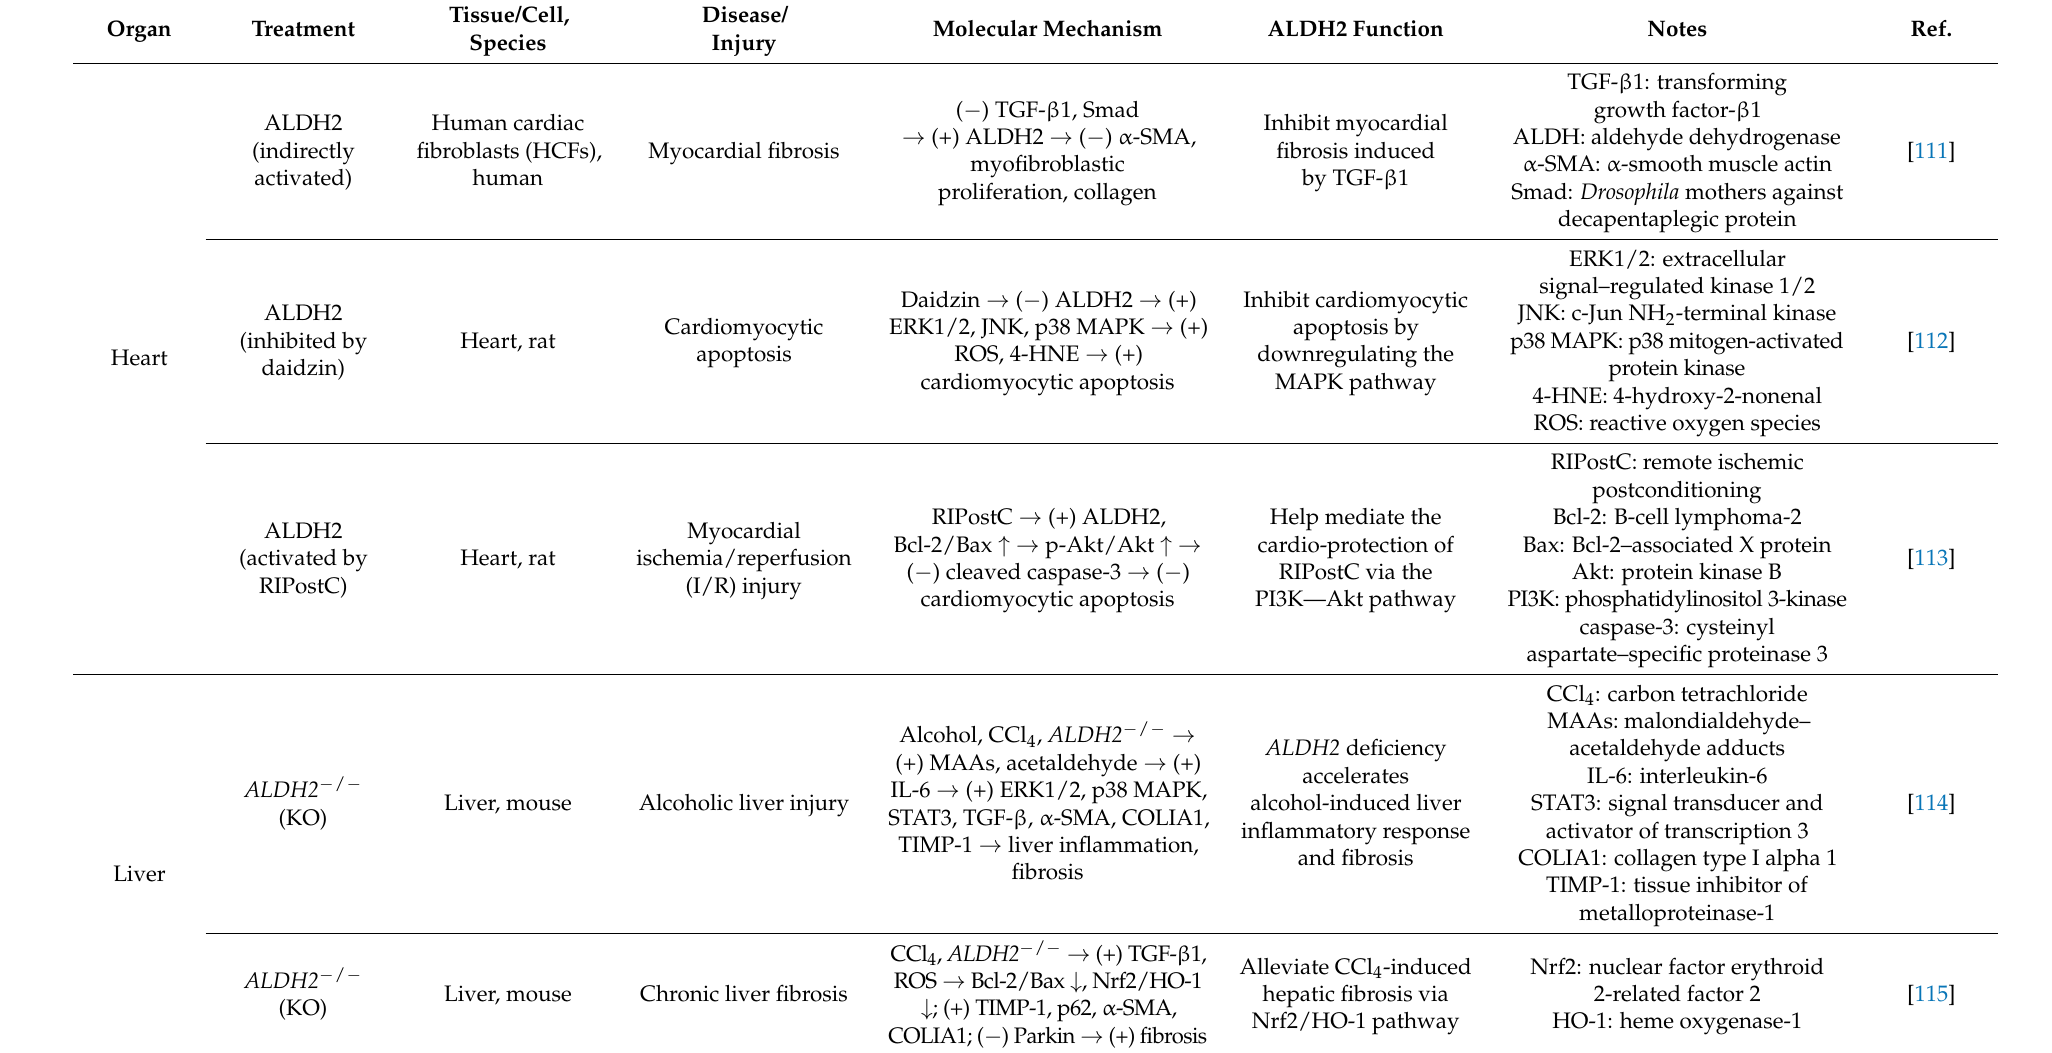
Table 2. Function and regulatory pathways of ALDH2 in oxidative stress-related diseases and